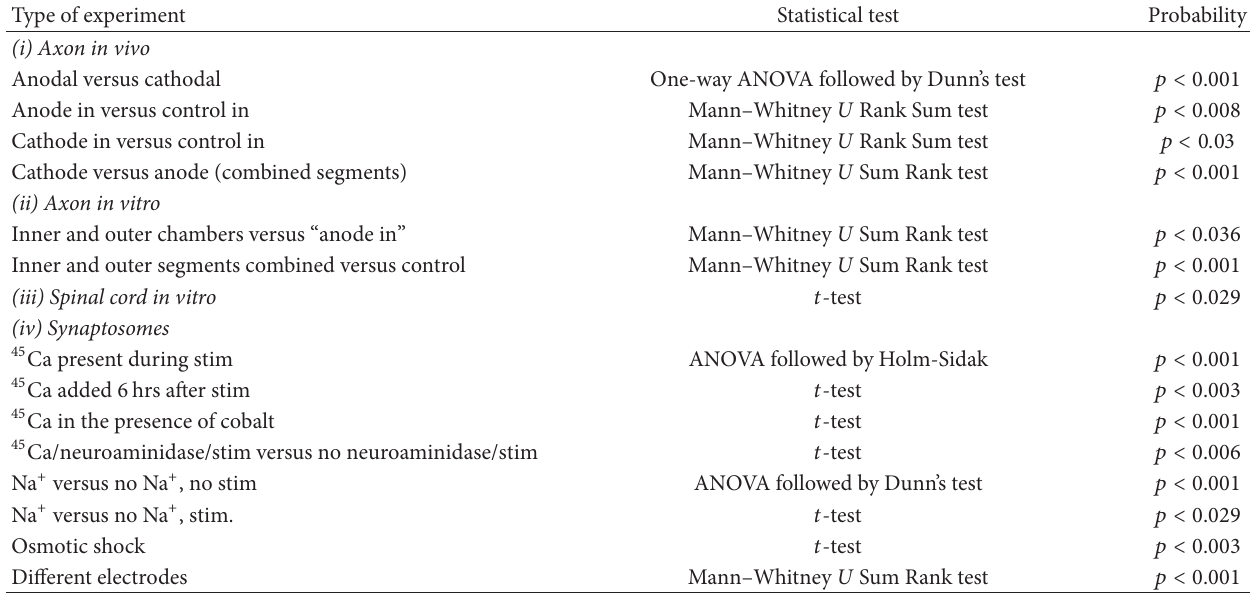
Table 1: Neuronal preparations and statistical tests used to evaluate DC-induced calcium